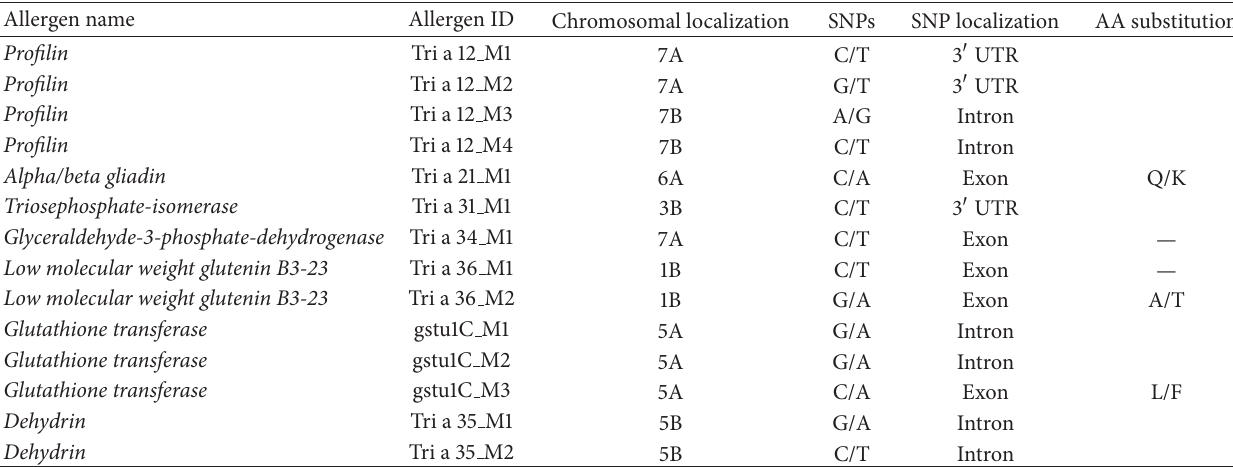
Table 3: Polymorphism detected for wheat allergen alleles in a collection of 240 wheat genotypes. Chromosomal localization, SNPs type, number of lines carrying each allele, SNP localization, and amino acidic substitution detection were